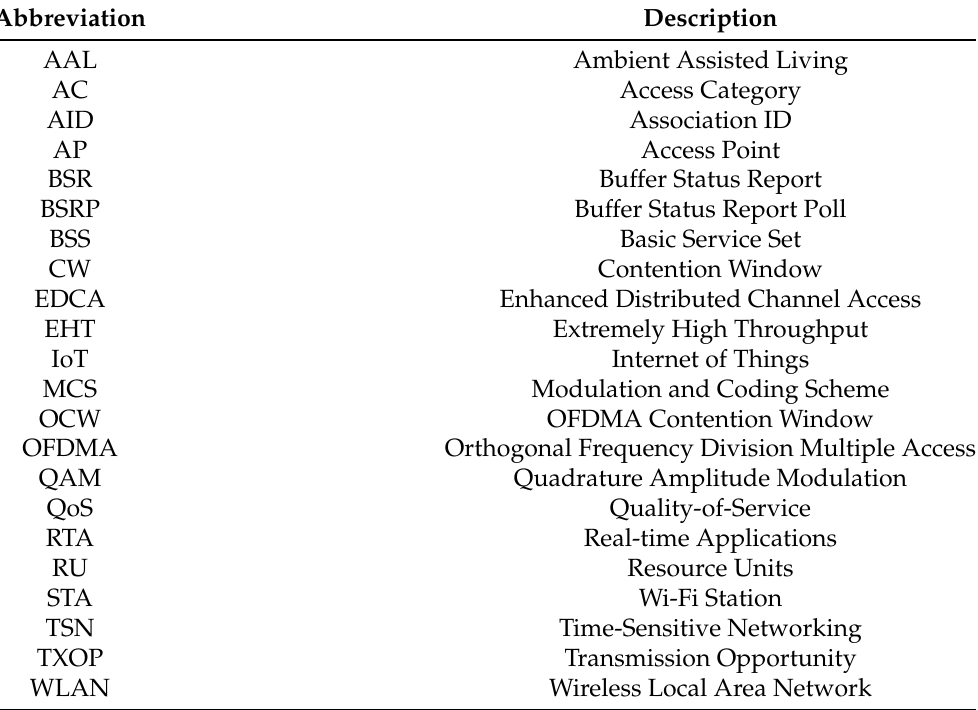
Table 1. List of abbreviations used in the